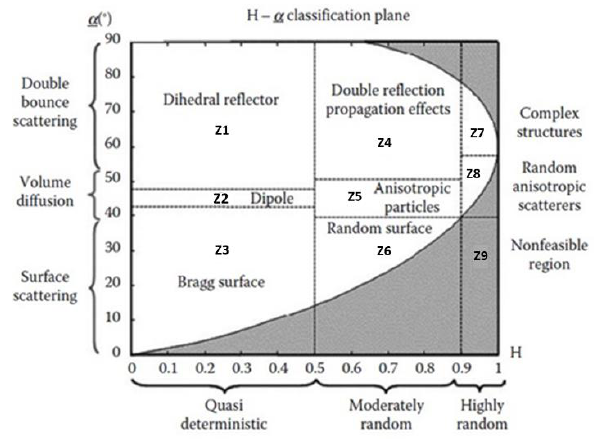
Figure 2. H-α classification plane (Jagdhuber et al.,